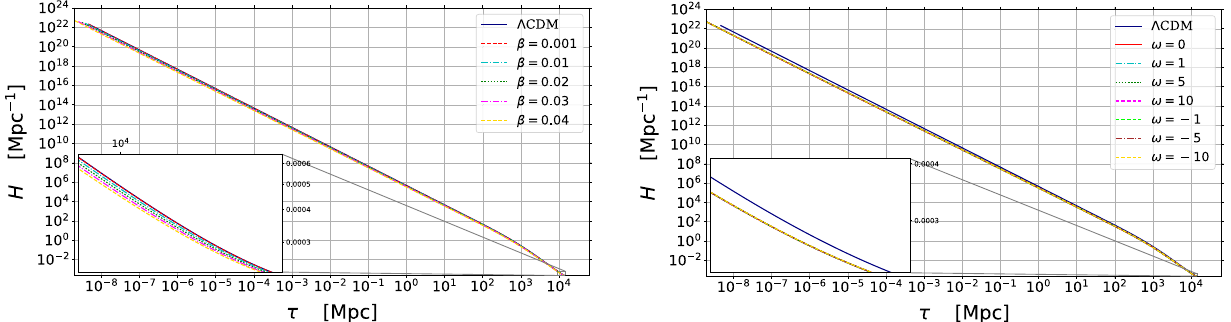
Fig. 3 Hubble parameter in term of conformal time for different values of β compared to (cid:3) CDM model, where ω = 0 (left), and analogous diagrams for different values of ω , regarding β = 0 . 04